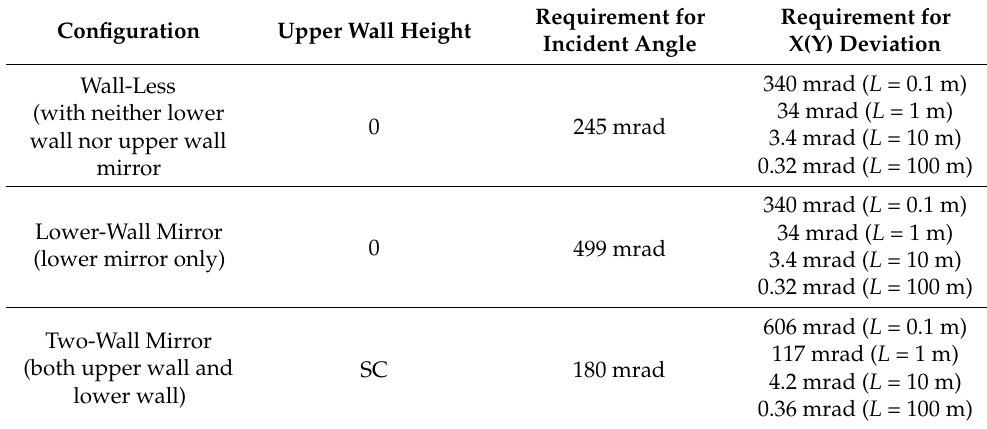
Table 1. Requirement for Beam Incident Angle and Deviation in X(Y) Direction with Upper and Lower Wall Mirror